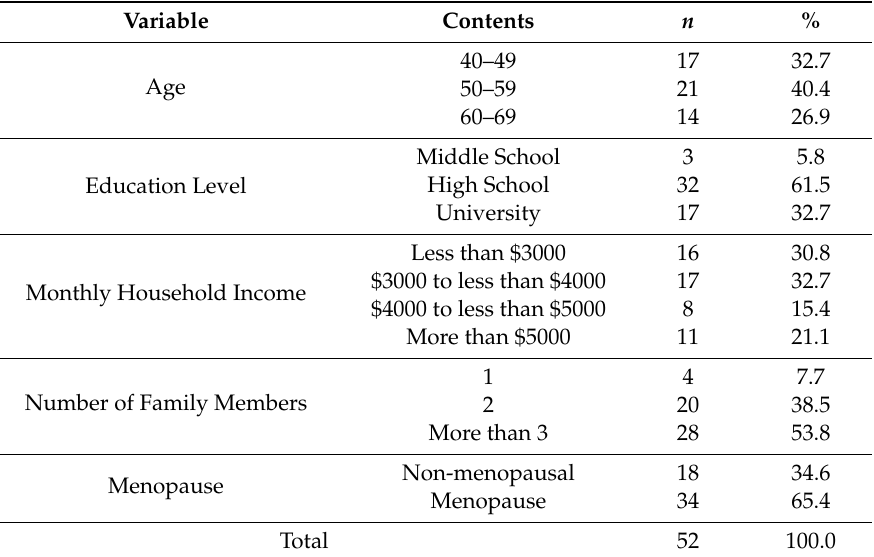
Table 1. Characteristics of